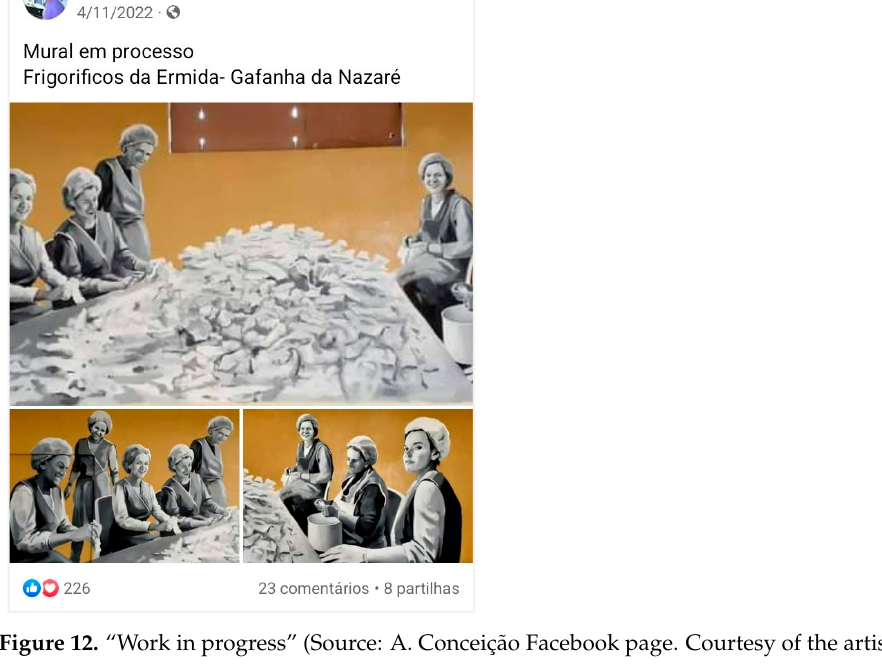
Figure 12. “Work in progress” (Source: A. Conceição Facebook page. Courtesy of the artist).